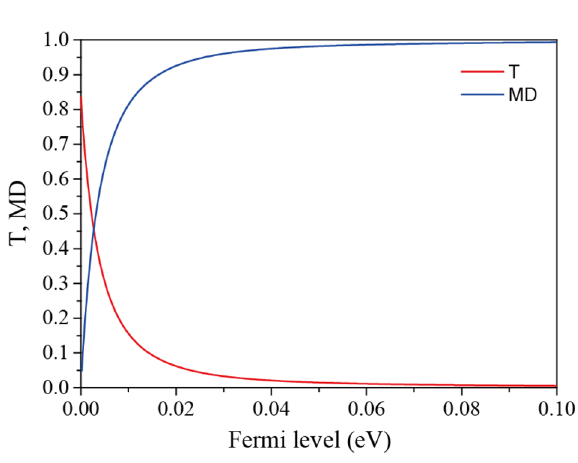
Figure 3. ( a ) Transmission, reflection, and absorption curves of the modulator at the EIT-like transmission frequency. ( b ) Propagation length of the bottom waveguide comprising a five-layer structure (air–SiO 2 ( t 2 )– graphene–SiO 2 (10 m)–graphene–air). ( c ) Electric field distribution of the modulator for Fermi level variation from E